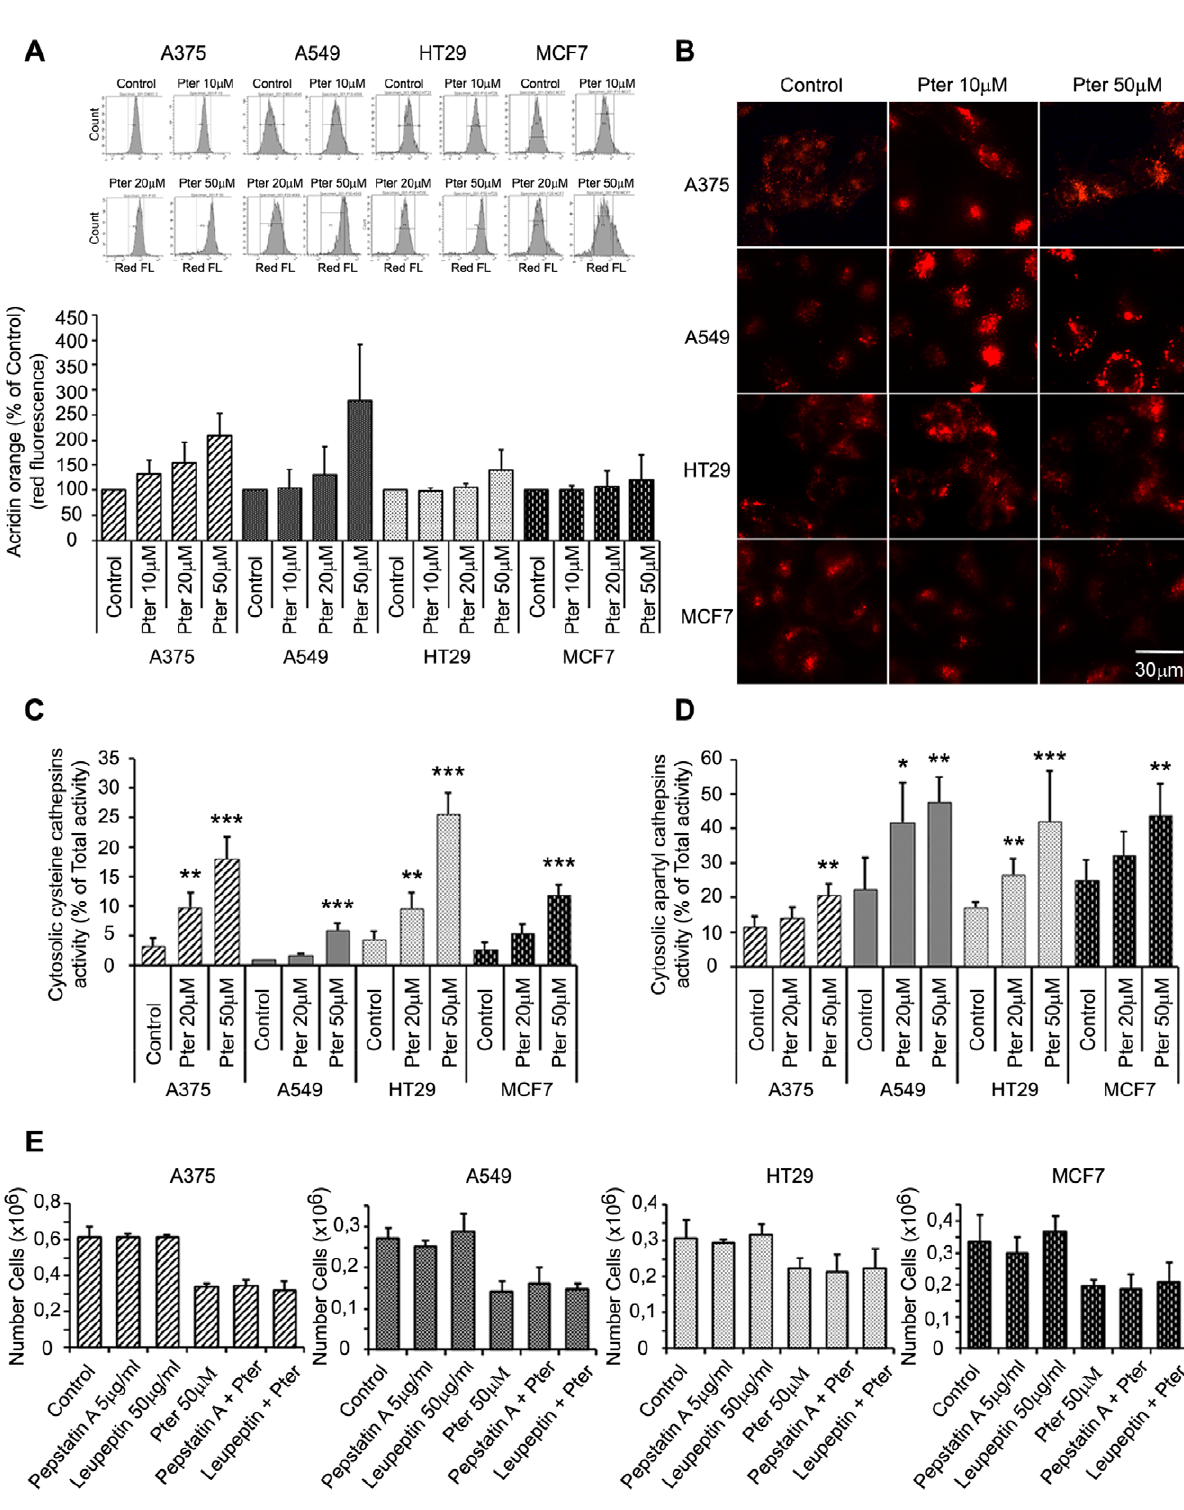
PLOS ONE | www.plosone.org